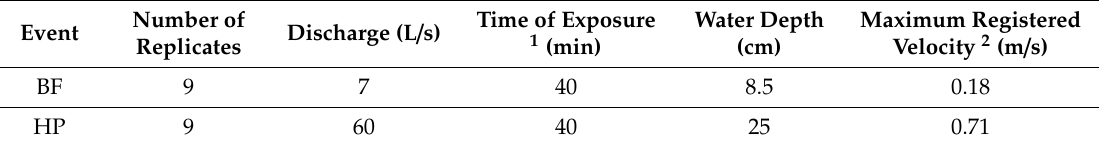
Table 1. Flow events tested, base-flow (BF) and hydropeaking (HP), for each tested L-structure (wood and acrylic) with the respective discharge (L / s), time of exposure (min), water depth (cm), and maximum measured velocities in the flume (m /